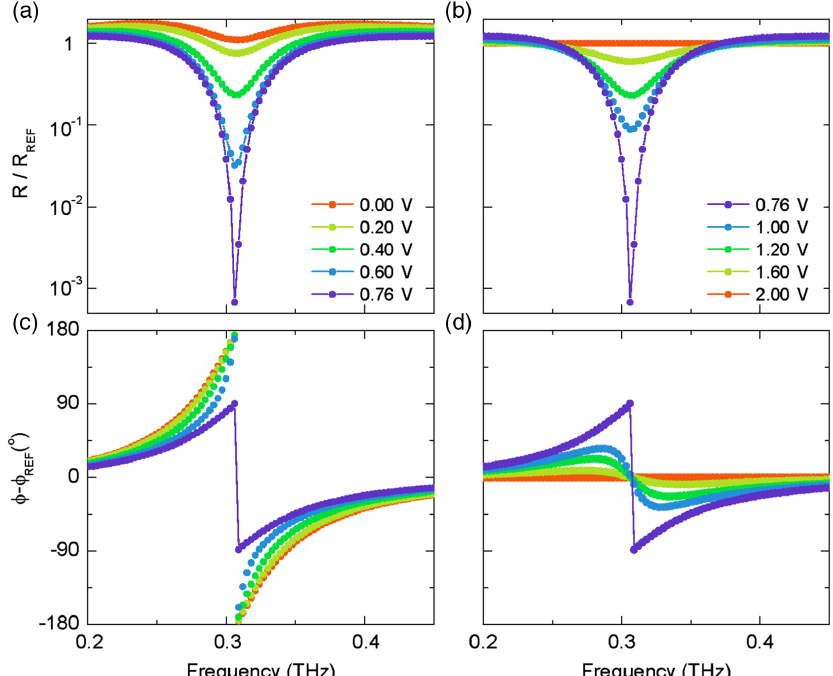
FIG. 6. FDFD simulations for the experiments described in Fig. 2. (a),(b) Variation of the reflectance ( R ¼ j r j 2 ) with the relative gate voltage Δ V . A critical transition occurs at Δ V g respectively. The spectrum calculated at Δ V Δ V ≥ Δ V , respectively. The simulated system has geometrical parameters identical to those of the system studied in Fig. 2. g c